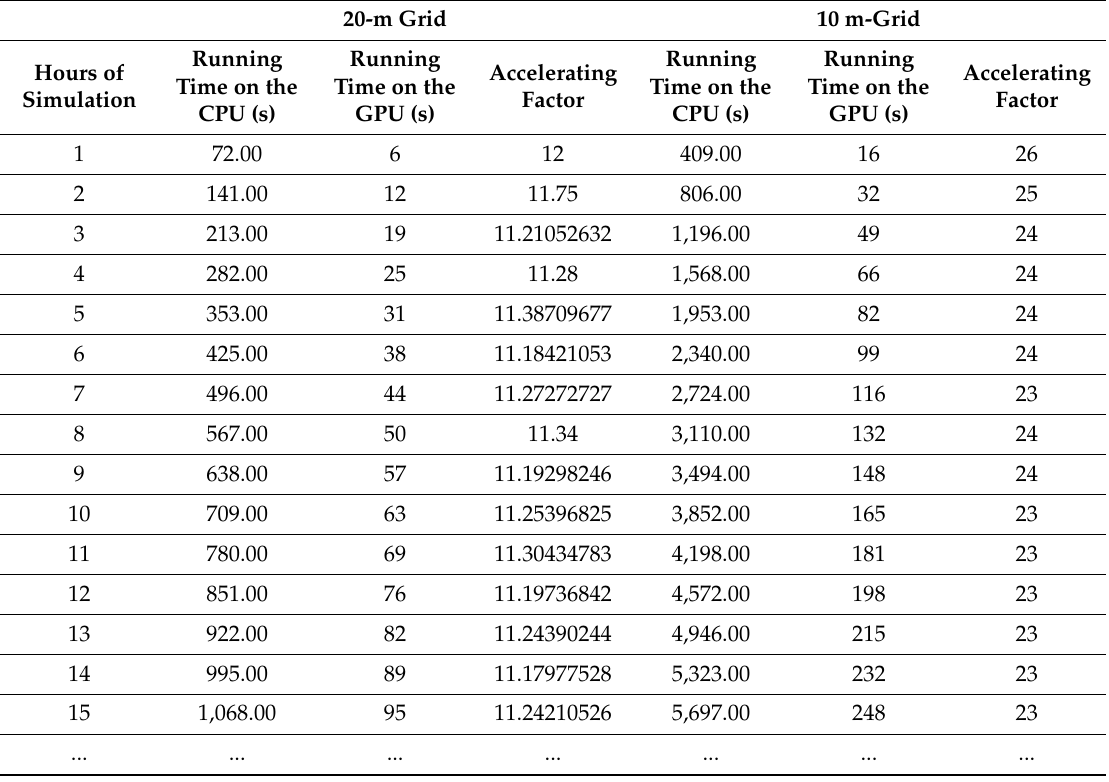
Table3. AdirectcomparisonofrunningtimesontheCPU(a)andGPU(b)for20m-and10m-gridsimulations.